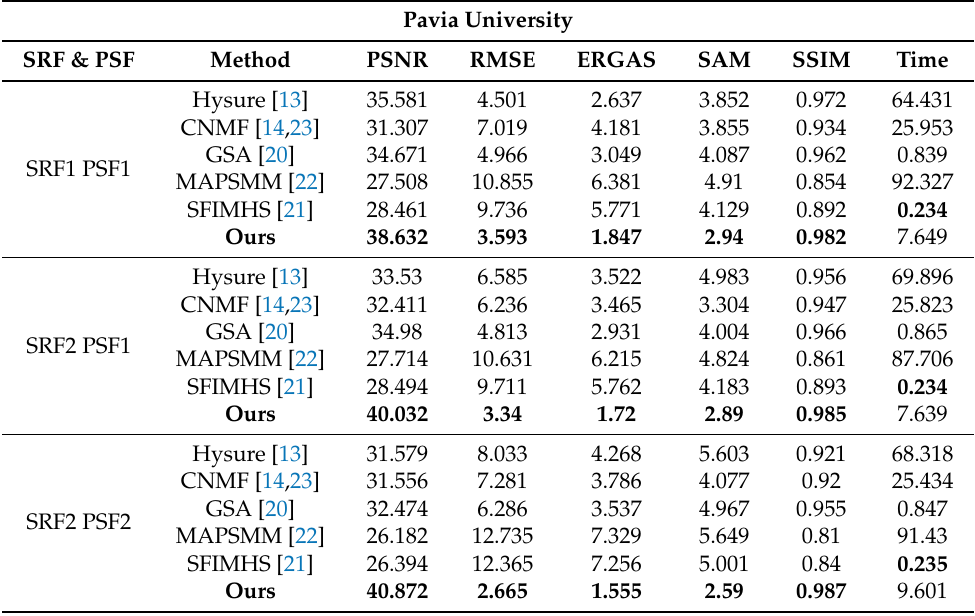
Table 4. Objective evaluation metrics for the fusion results of the six blind fusion methods in the paper on the Pavia University dataset.